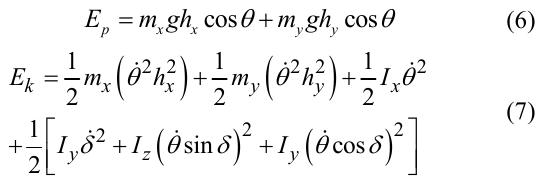
Table 1: A literature summary of control strategies for bicyrobo Objectives Methods to tackle a ce s n e e r e f R [13] Self-stabilizing strategy Sliding Patch Theory